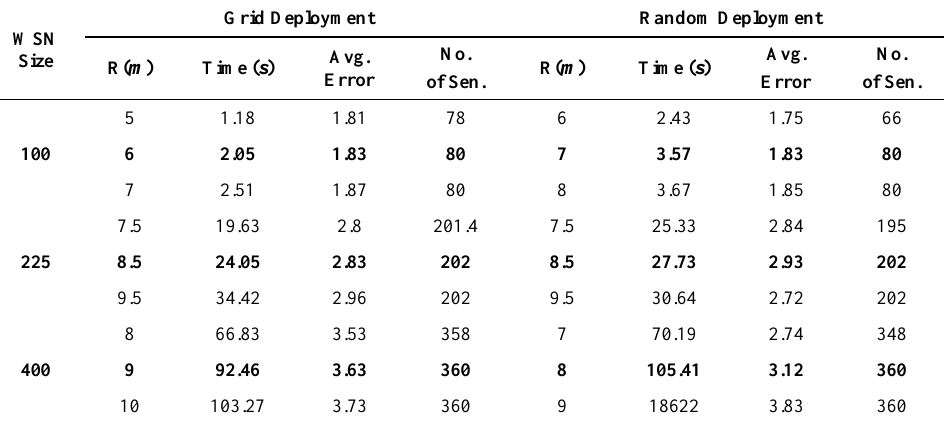
Table 2. Result of modified-APIT